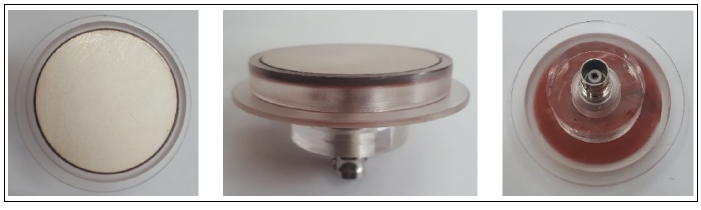
Figure 2. Ultrasonic emitter used.